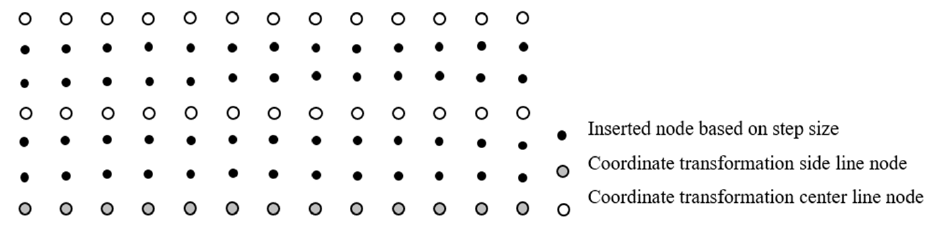
Figure 4. Coordinate transformation of road skeleton nodes.